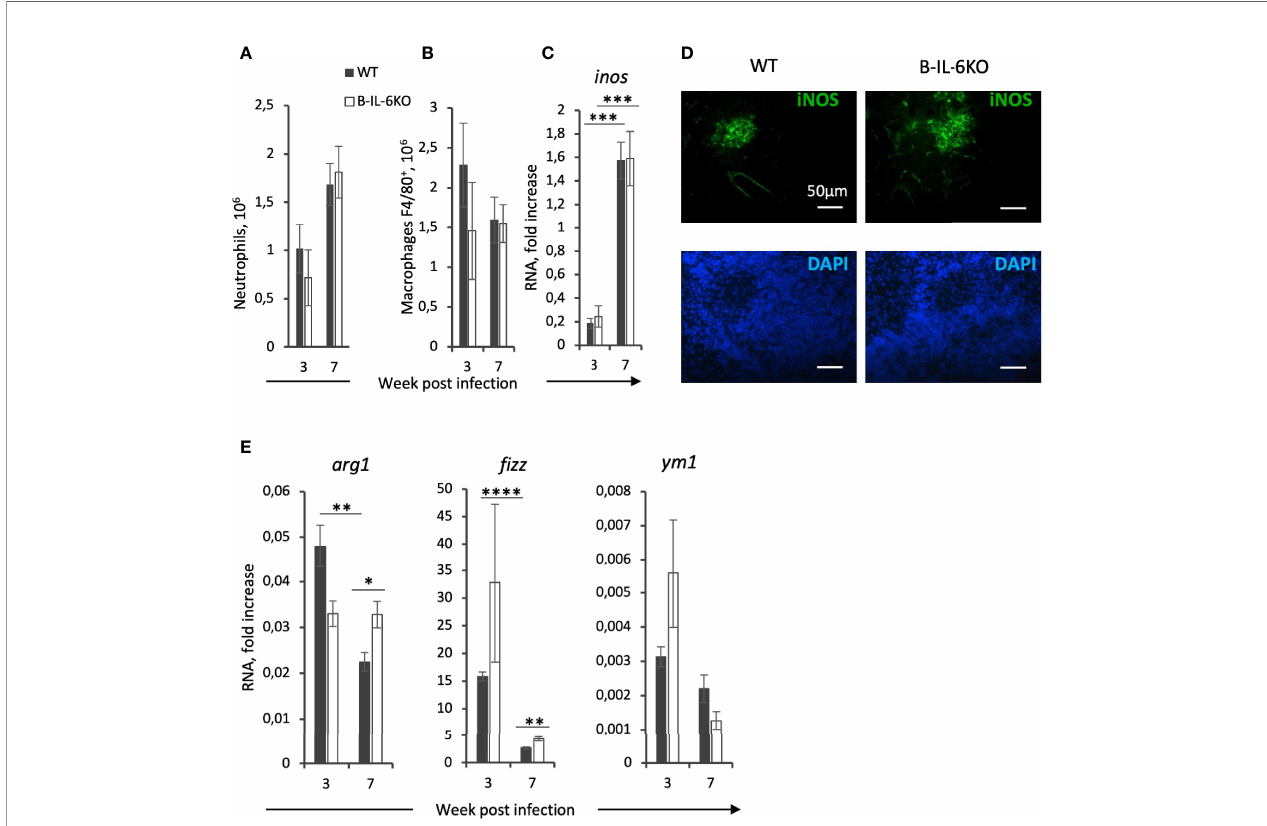
FIGURE 5 | Macrophages from infected lungs display general M1-centered polarization only marginally modi fi ed by the absence of B-cell-derived IL-6. The content of Ly6G + neutrophils (A) and F4/80 + macrophages (B) in the lungs of WT and B-IL-6KO mice, revealed by fl ow cytometry. (C) Elevation in the inos gene expression between weeks 3 and 7 post challenge, and (D) immune histochemical staining of iNOS-positive cells within TB granulomata at week 7 post infection. (E) qPCR measurements of arg1, fi zz , and ym1 RNAs in the lung tissue at weeks 3 and 7 post infection. See the legend for Figure 3 . *P < 0,05, **P < 0,01, ***P < 0,001, ****P <